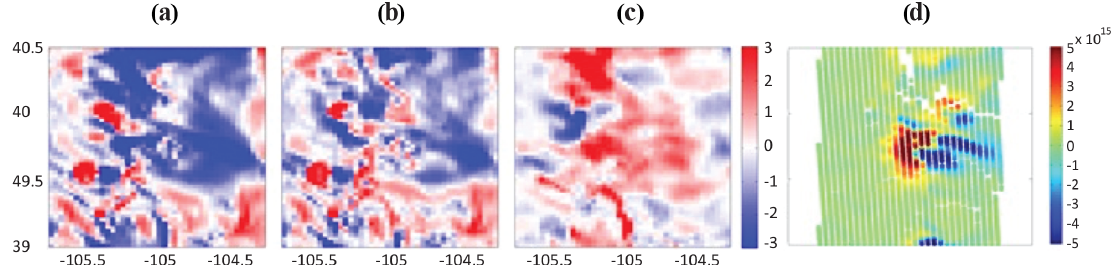
Figure 2. The U wind state variable at 07:00UTC on 4 July (a) prior minus truth, (b) posterior minus truth, (c) posterior minus prior and (d) the difference between the prior TEMPO NO 2 column and the truth.